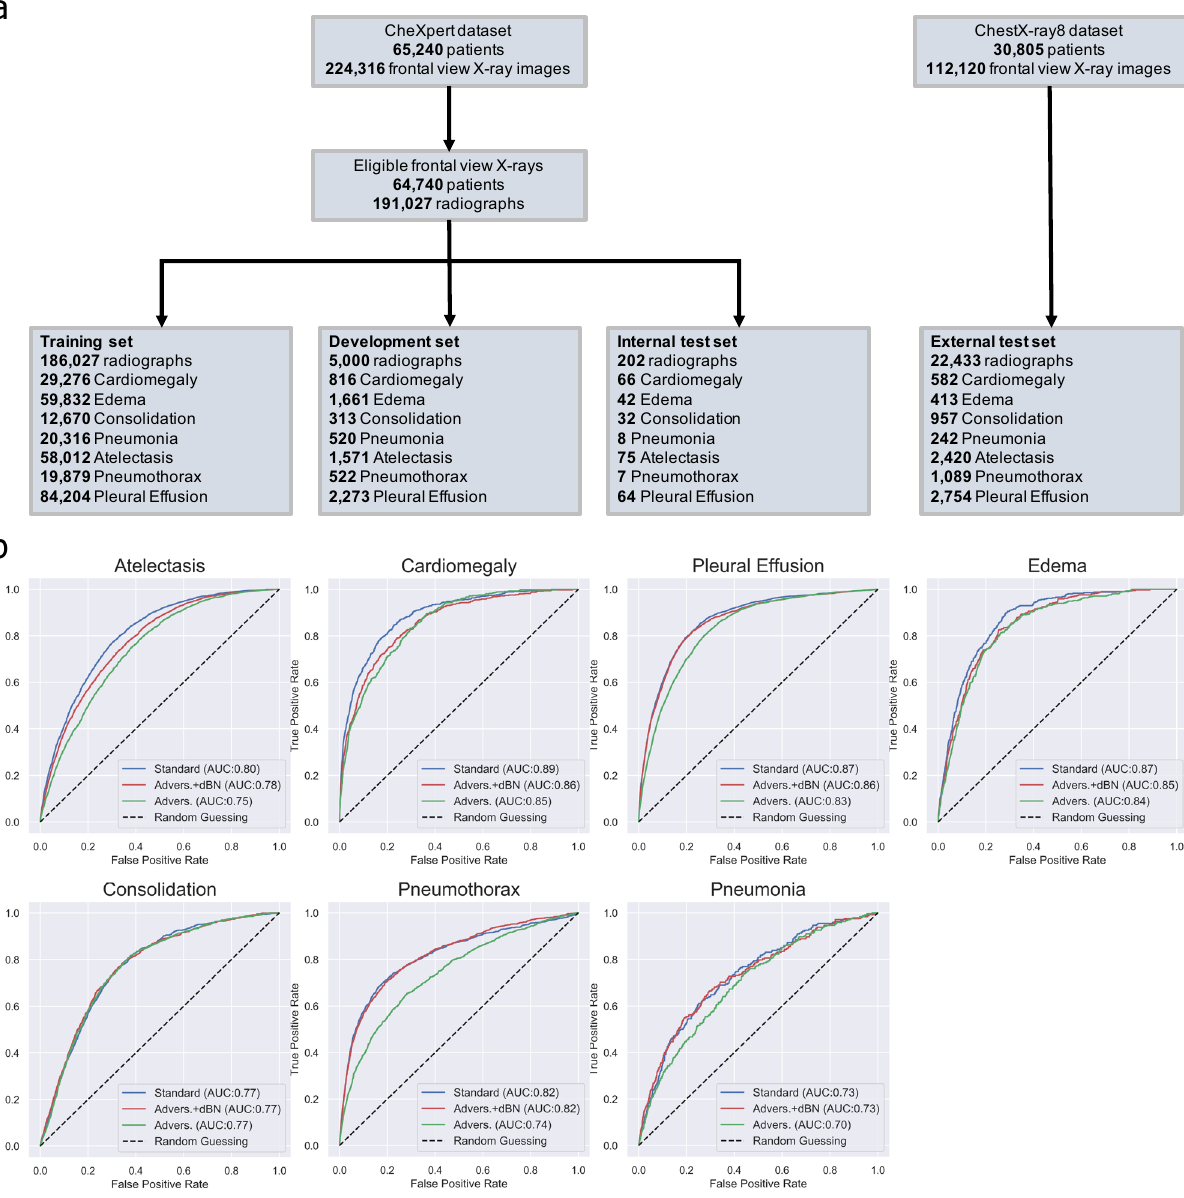
Fig. 4 Validation of models on an external dataset (ChestX-ray8). a Schematic of the data selection process. b AUC of the standard model (blue) and the adversarially trained models with (red) and without (green) dual batch norms on an independent test set of 22,433 radiographs from the ChestX-ray8 dataset. Dual batch norm training resulted in better AUC, closely matching the performance of the standard